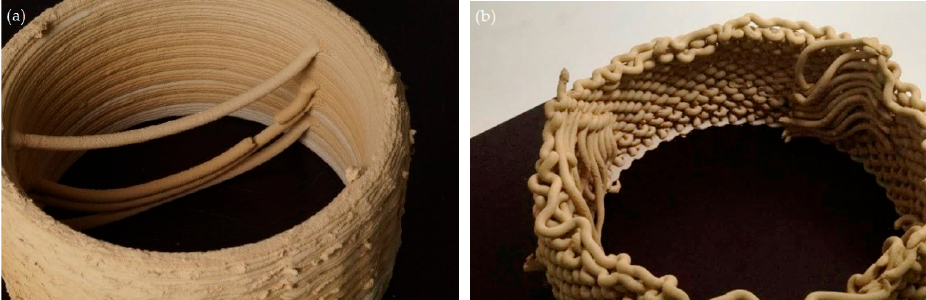
Figure 2. ‘Second-row material deposition’ due to the interaction of path instruction and material properties ( a , b )